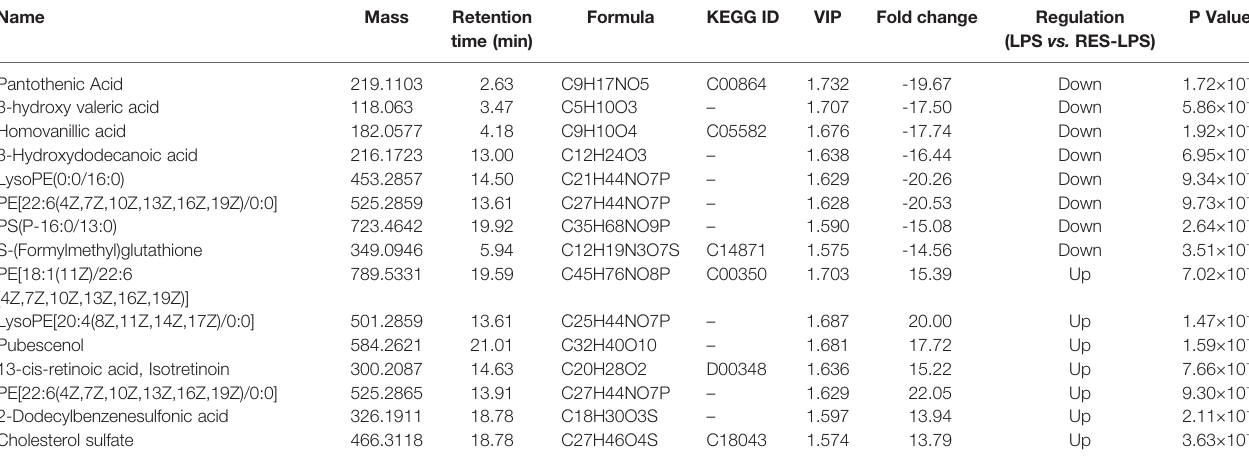
TABLE 2 | Differential metabolites identi fi ed in serum samples of the LPS and RES – LPS groups.